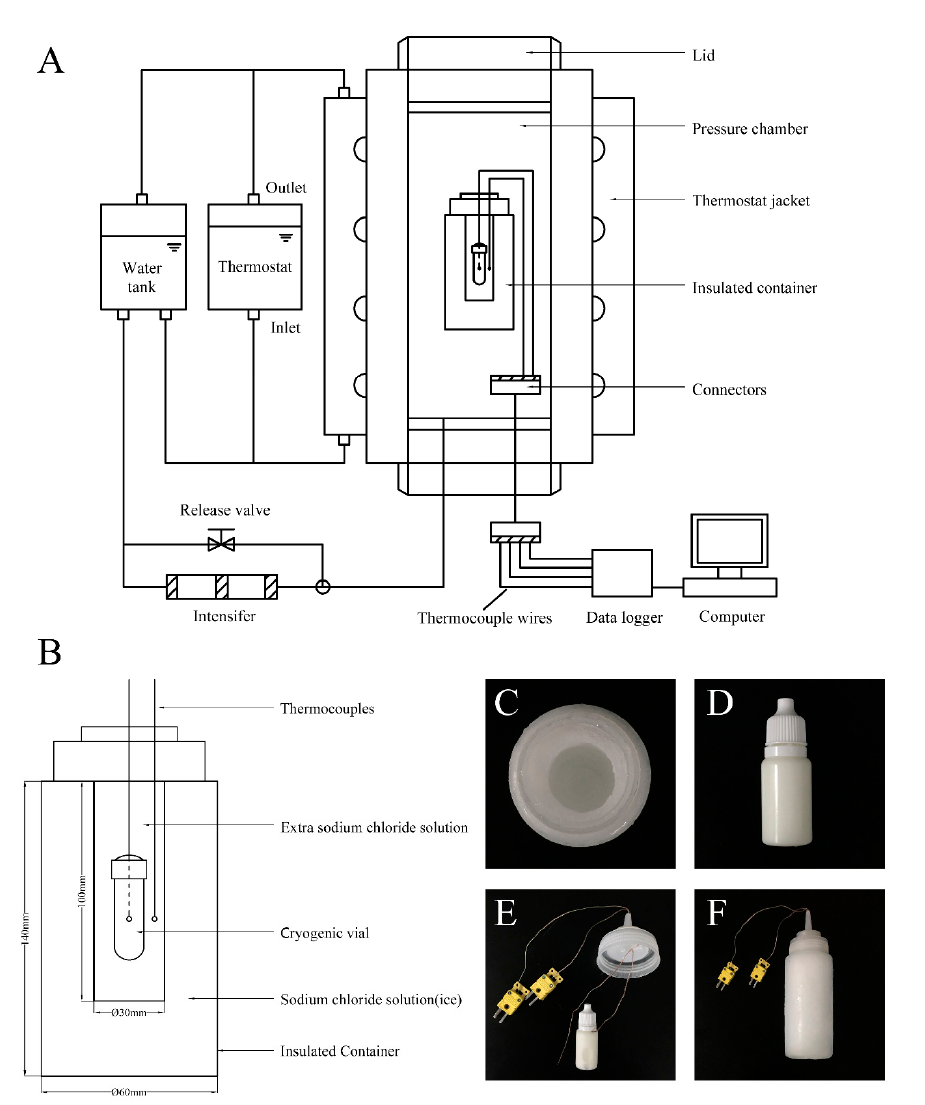
Figure 1. ( A ) Schematic diagram of the experimental high-pressure apparatus. ( B ) Schematic cross-section diagram of the insulated container. ( C ) The ice hole created by pulling out the centrifuge tube after freezing. ( D ) The cryogenic vial filled with inoculated pasteurized milk. ( E ) The thermocouples inserted into the plastic cap and cryogenic vial. ( F ) The screwed-on insulated